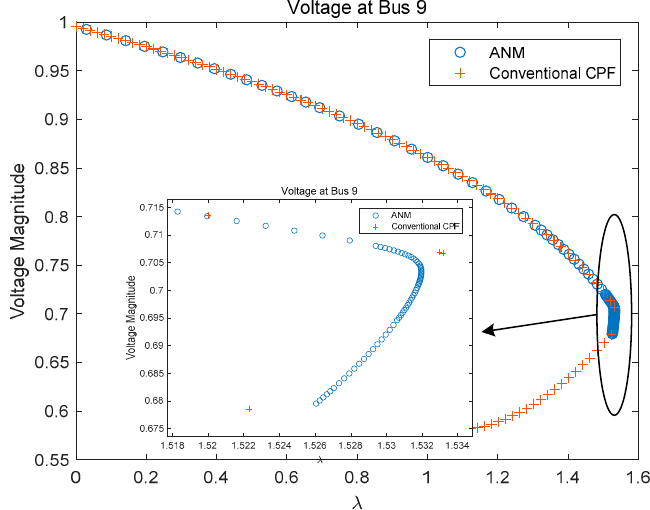
Figure 6. V-lambda curve of bus 9 for both methods.